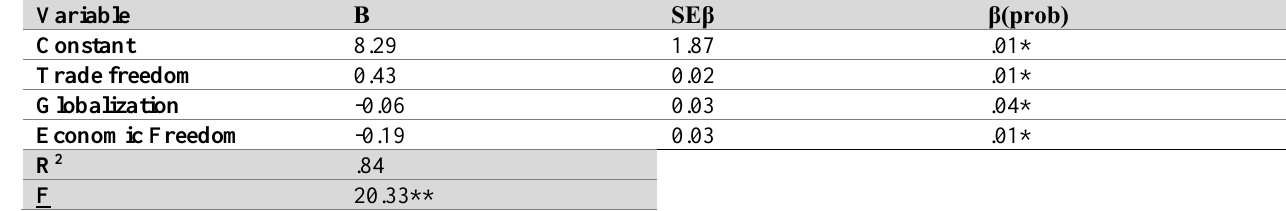
Summary of the OLS regression analysis on GCI